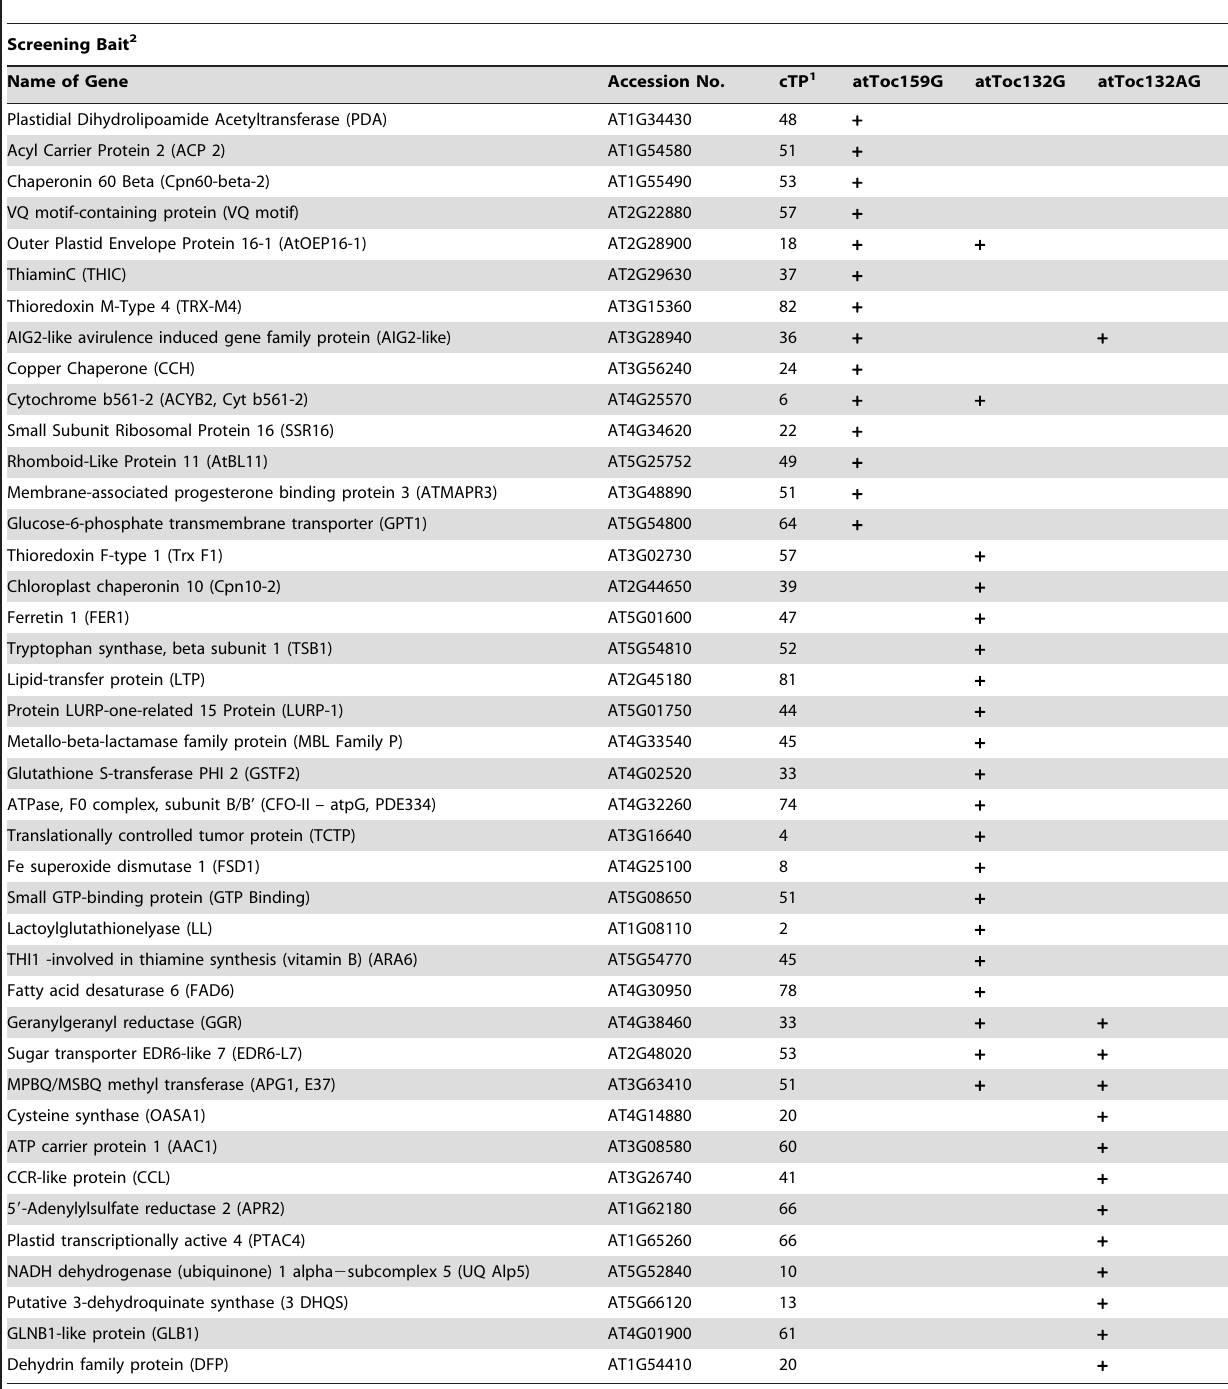
Table 1. List of plastid proteins with a non-photosynthetic function identified as interactors with atToc159G-, atToc132G- and atToc132AG-domain bait proteins in the split-ubiquitin yeast two-hybrid screen.